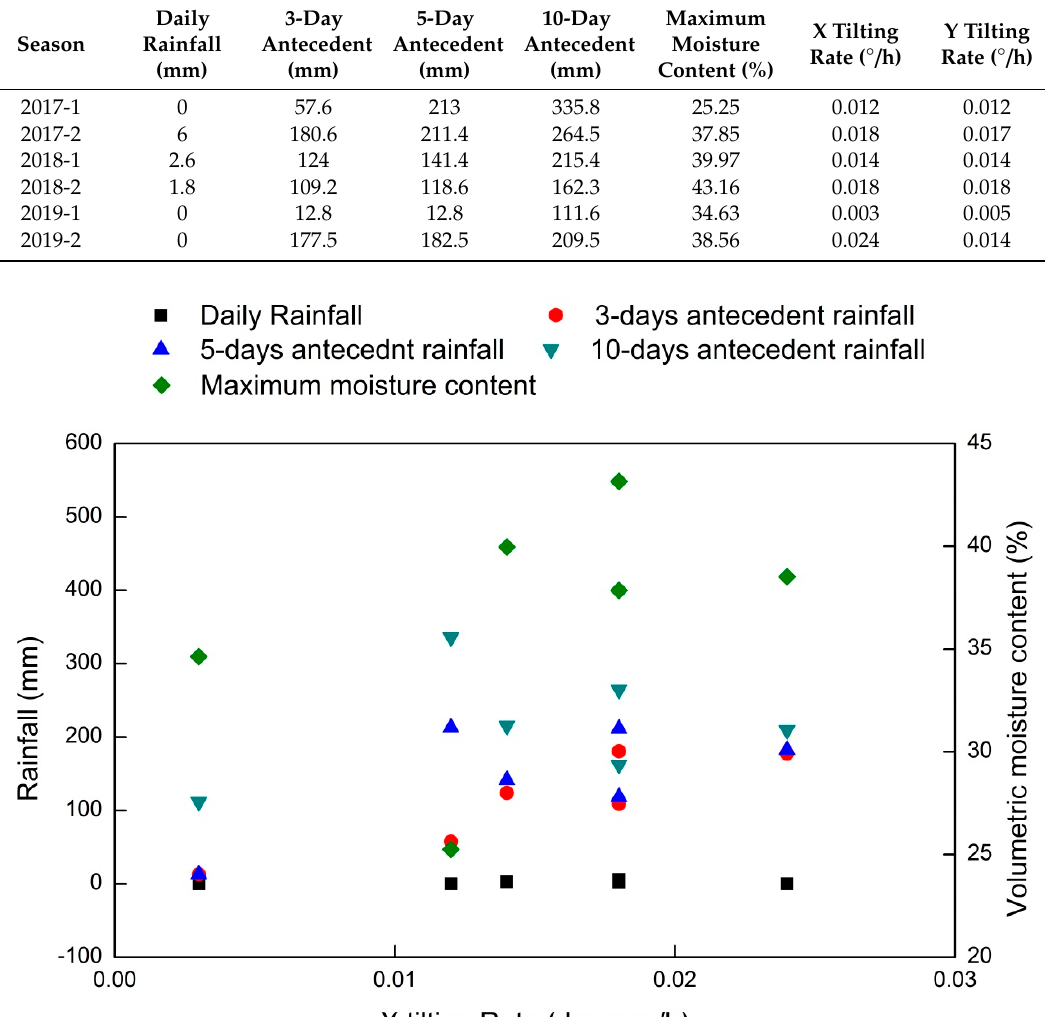
Table 2. Comparison of tilting rates with rainfall conditions at sensor 2.